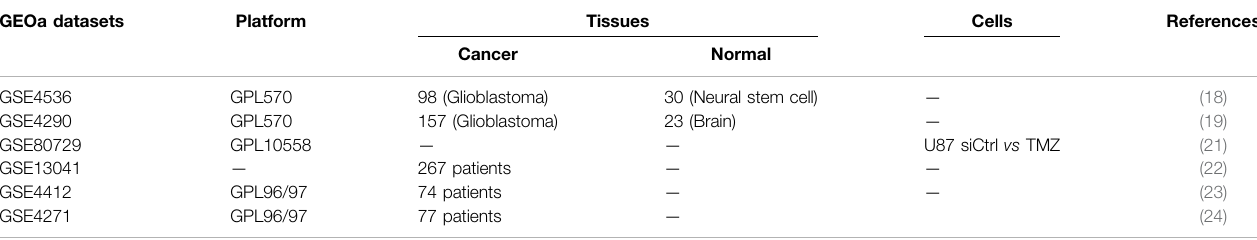
TABLE 1 | The primary characteristics of 6 GEO datasets on gene expression pro fi ling via microarray. GEOa datasets